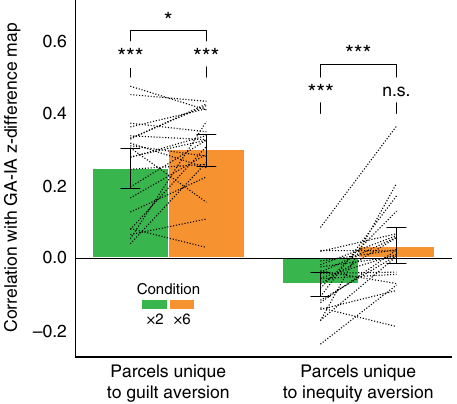
Fig. 5 Moral opportunists shift between guilt-averse and inequity-averse brain representations. Moral opportunists most strongly expressed the guilt aversion pattern in the condition where they employed guilt aversion computations (×6), and vice versa for inequity aversion in ×2. Bar height represents the mean over all moral opportunists; error bars represent bootstrapped 95% con fi dence interval; dashed lines connect pairs of data points from the same participant. * p < 0.05; *** p < 0.001; n.s. not signi fi cant; p -values from one-sample and paired-sample t